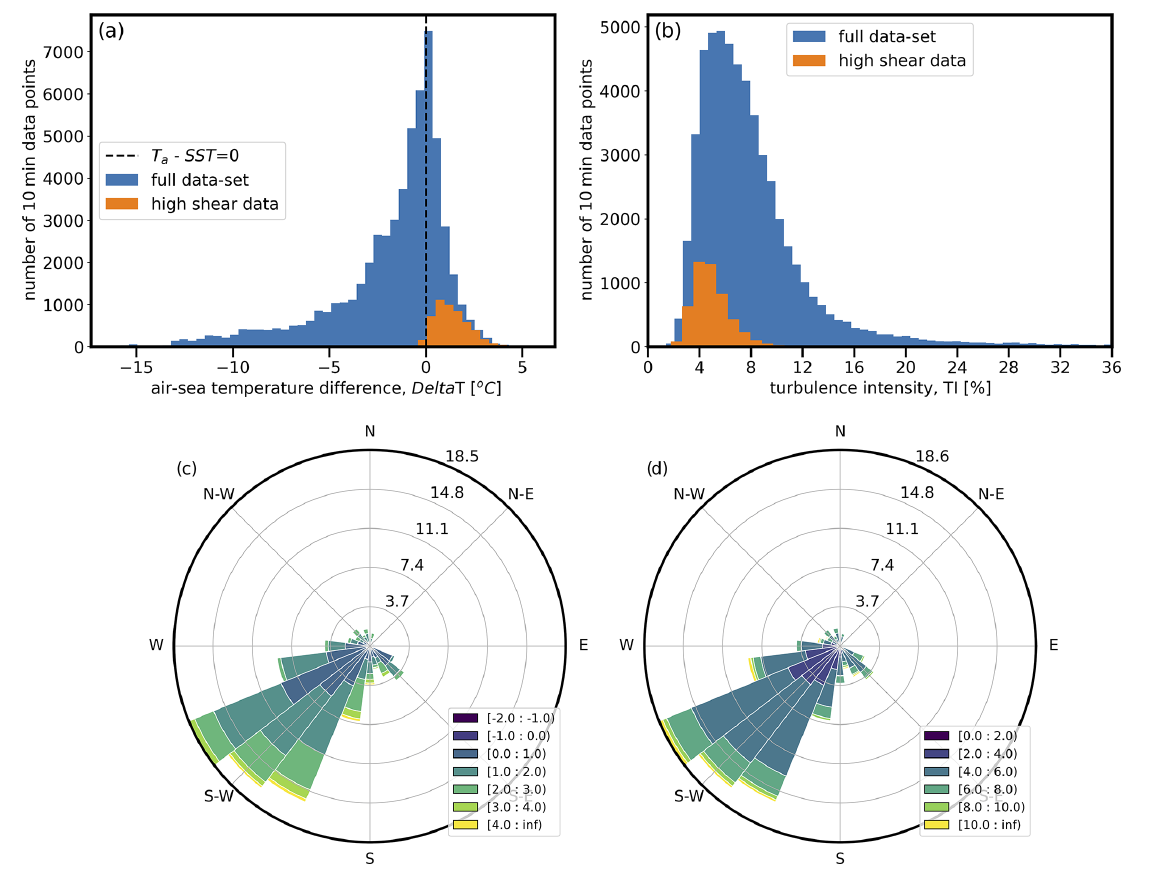
Figure 7. The impact of air–sea temperature difference on wind shear and turbulence intensity. Panels (a) and (b) show distribution for entire data set vs. periods in which high shear was detected. Panels (c) and (d) show distribution roses for high-shear periods only. Data are shown for NE buoy